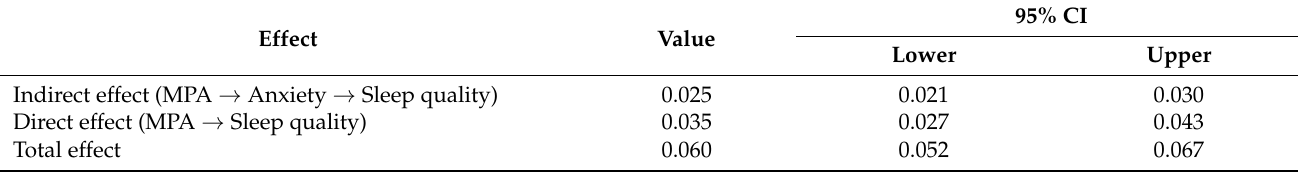
Table 3. Test for mediating